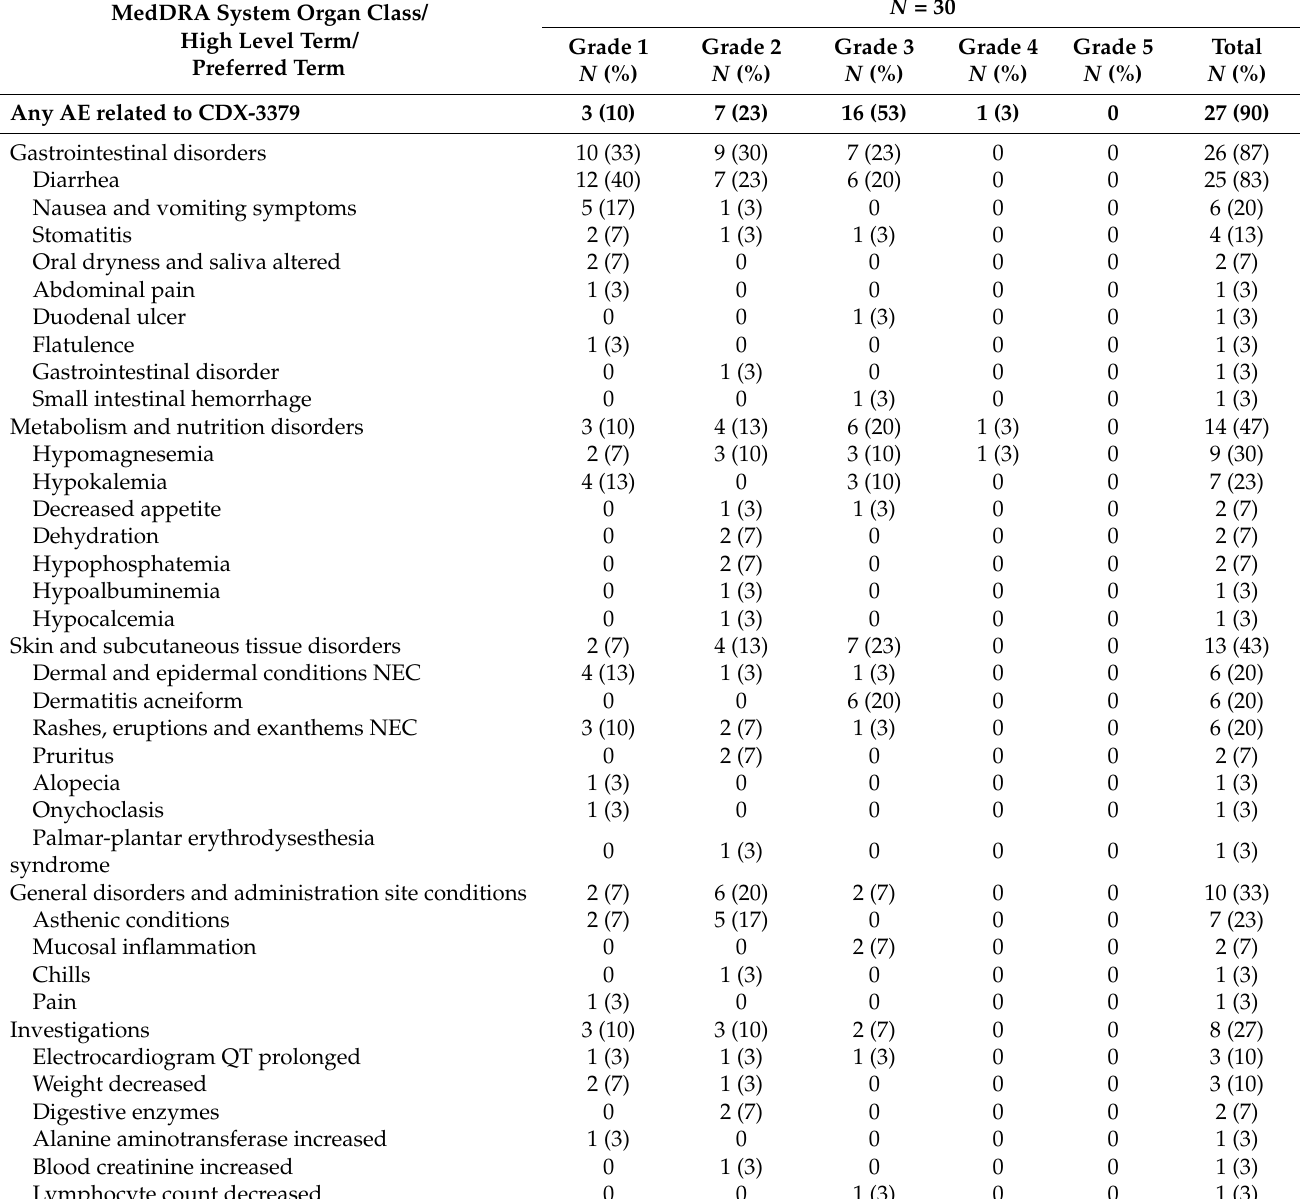
Table 2. Treatment-emergent adverse events related to protocol